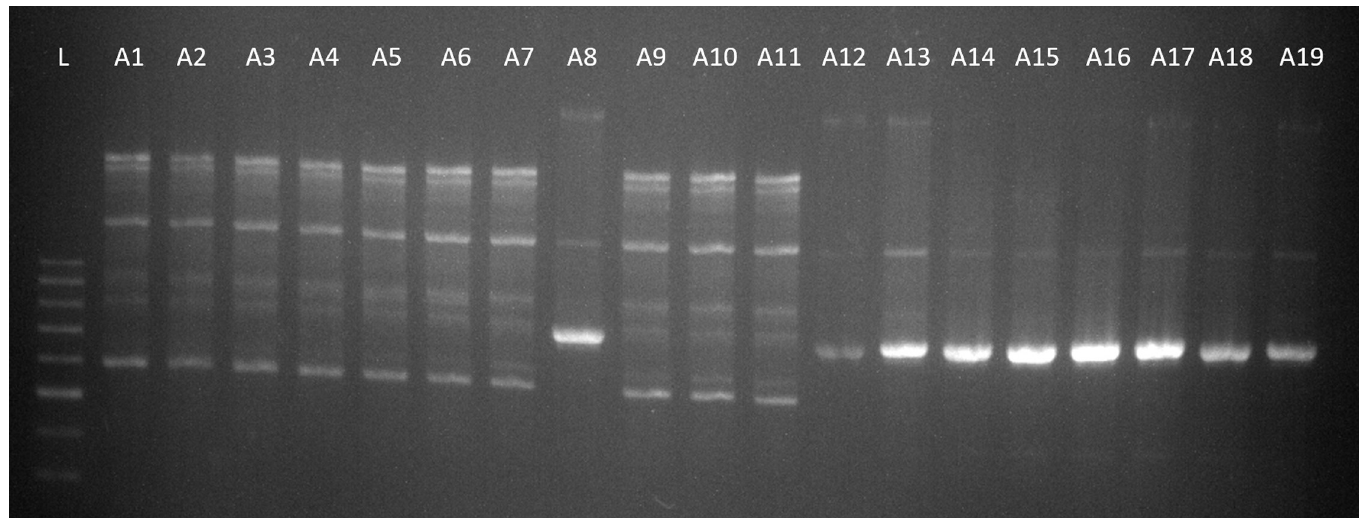
Fig 1. Corynebacterium amycolatum RAPD PCR types. L = ladder, strain 1.a = A1-A7, A9-A11; 2.a = A8, A12-A19 a . a A7, A8 are isolates from teat skin swabs.